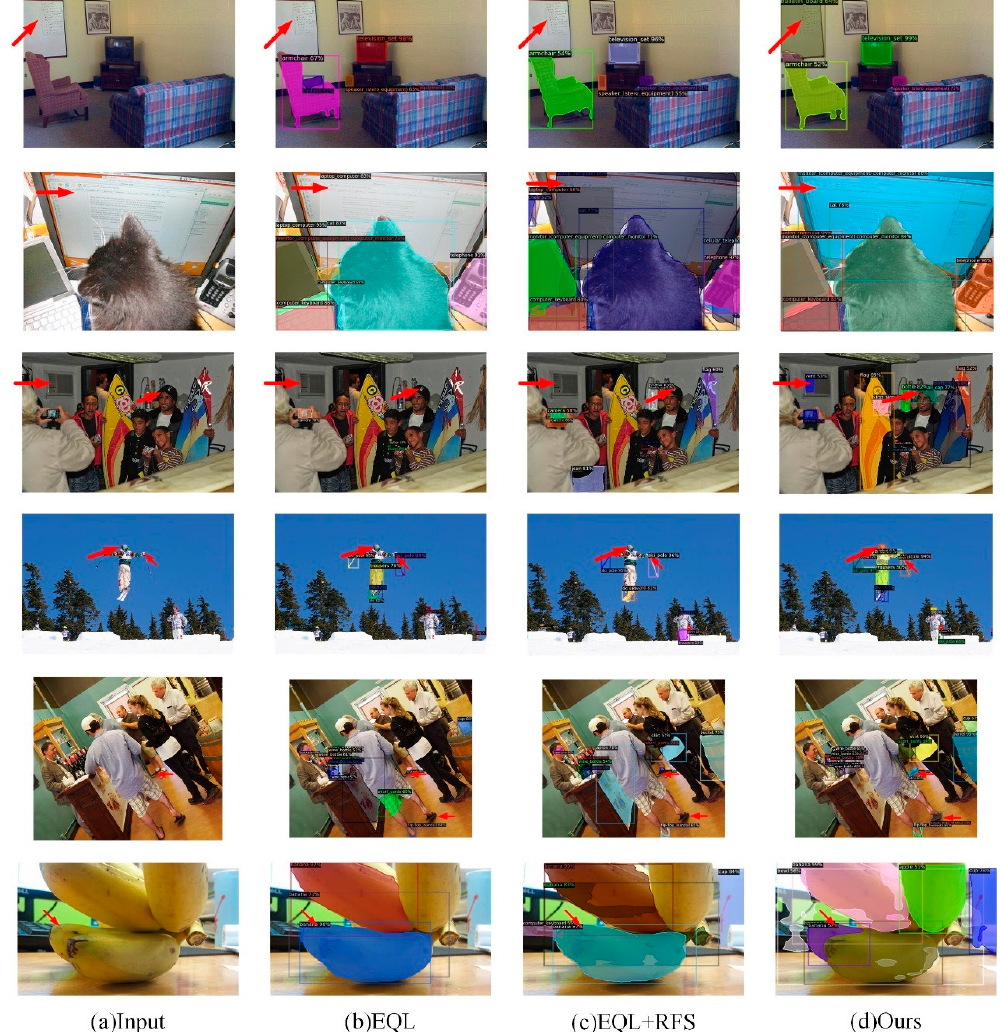
Figure 8. Visualization of experimental results.